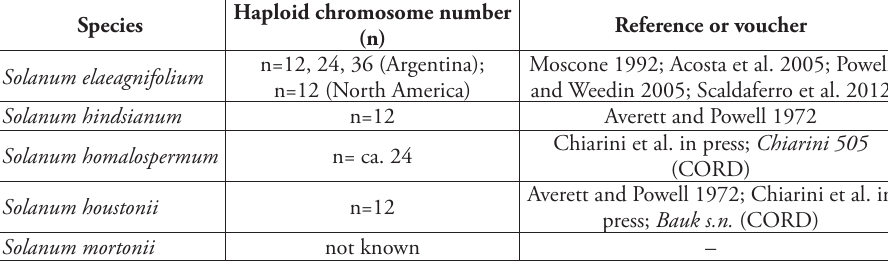
Table 1. Chromosome numbers in the Elaeagnifolium